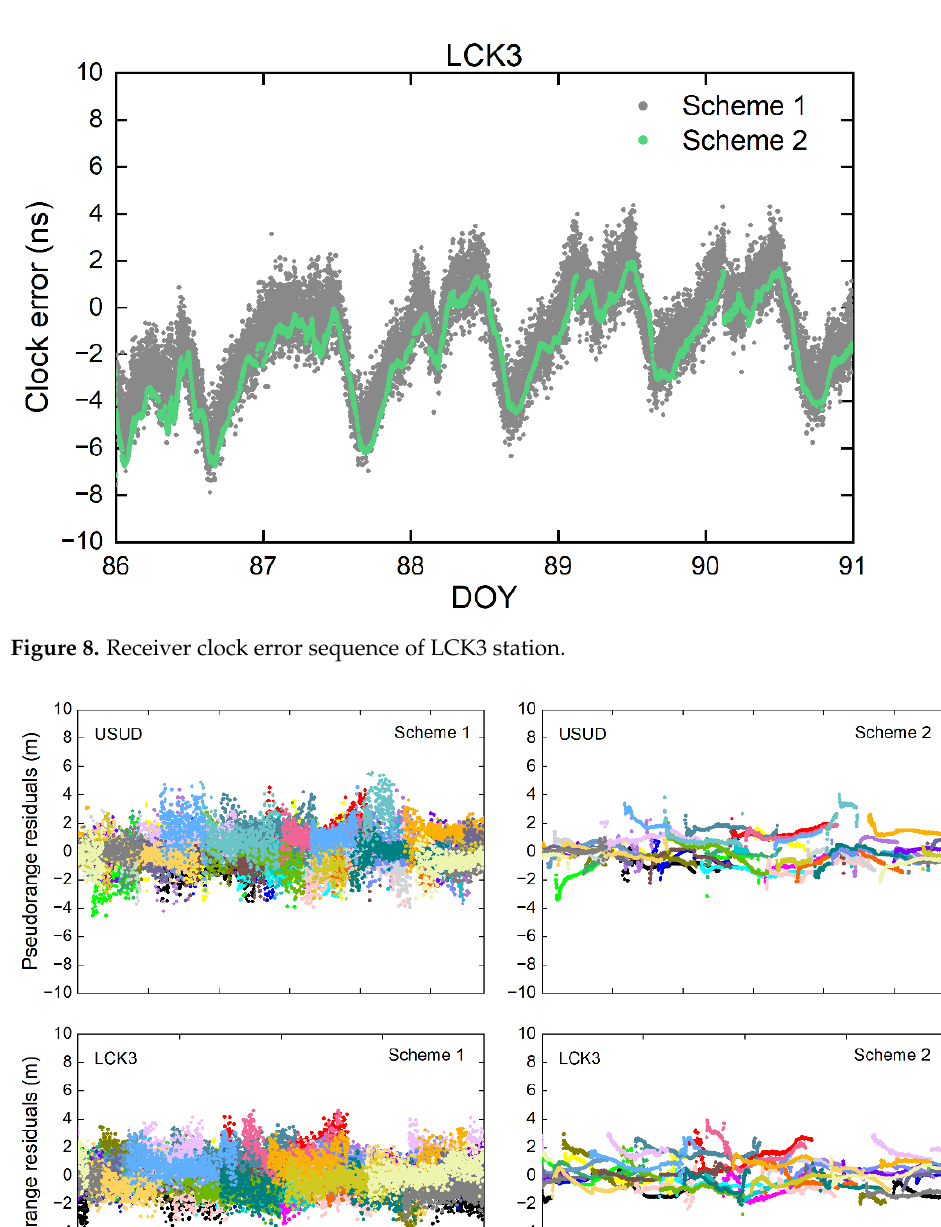
Figure 7. Receiver clock error sequence of USUD station.